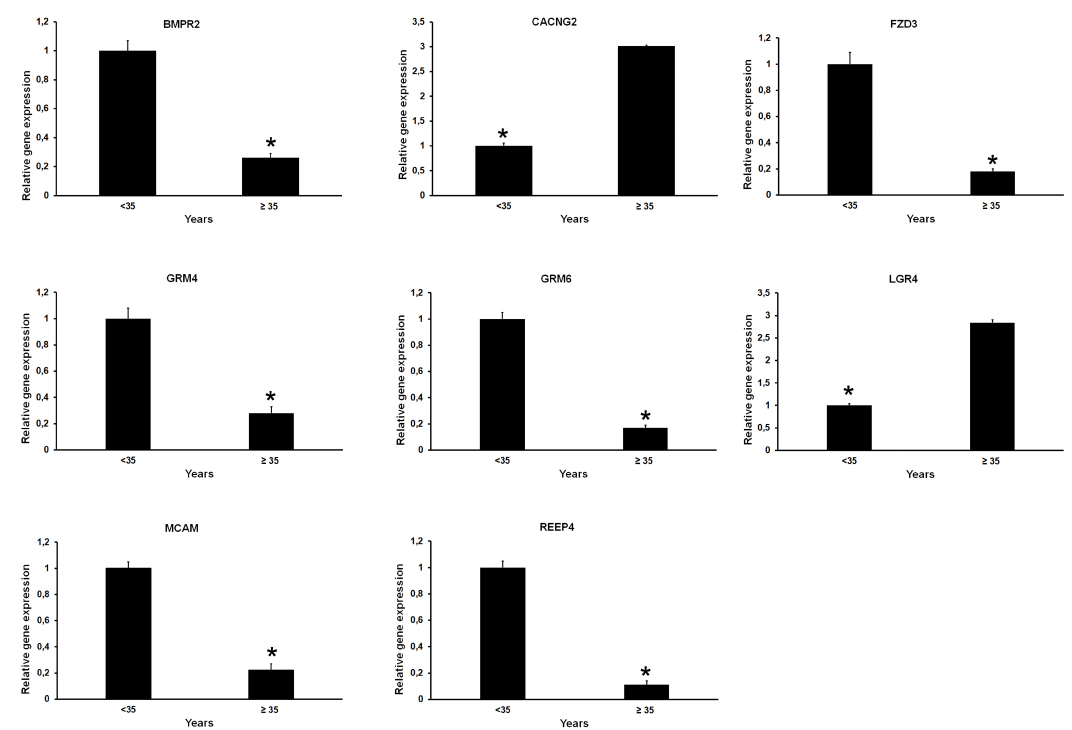
Figure 3. RNA-seq data validation. A subset of seven genes, BMPR2 , CACNG2, FZD3 , GRM4 , GRM6 , LGR4 and REEP4 , was validated in three technical replicates by RT-qPCR. These genes were chosen because they showed di ff erential expression between oocytes < 35 vs. ≥ 35 years. In addition, they are involved in important pathways for oocyte development and function (see Result section). Error bars represent standard deviation. * p < 0.05.